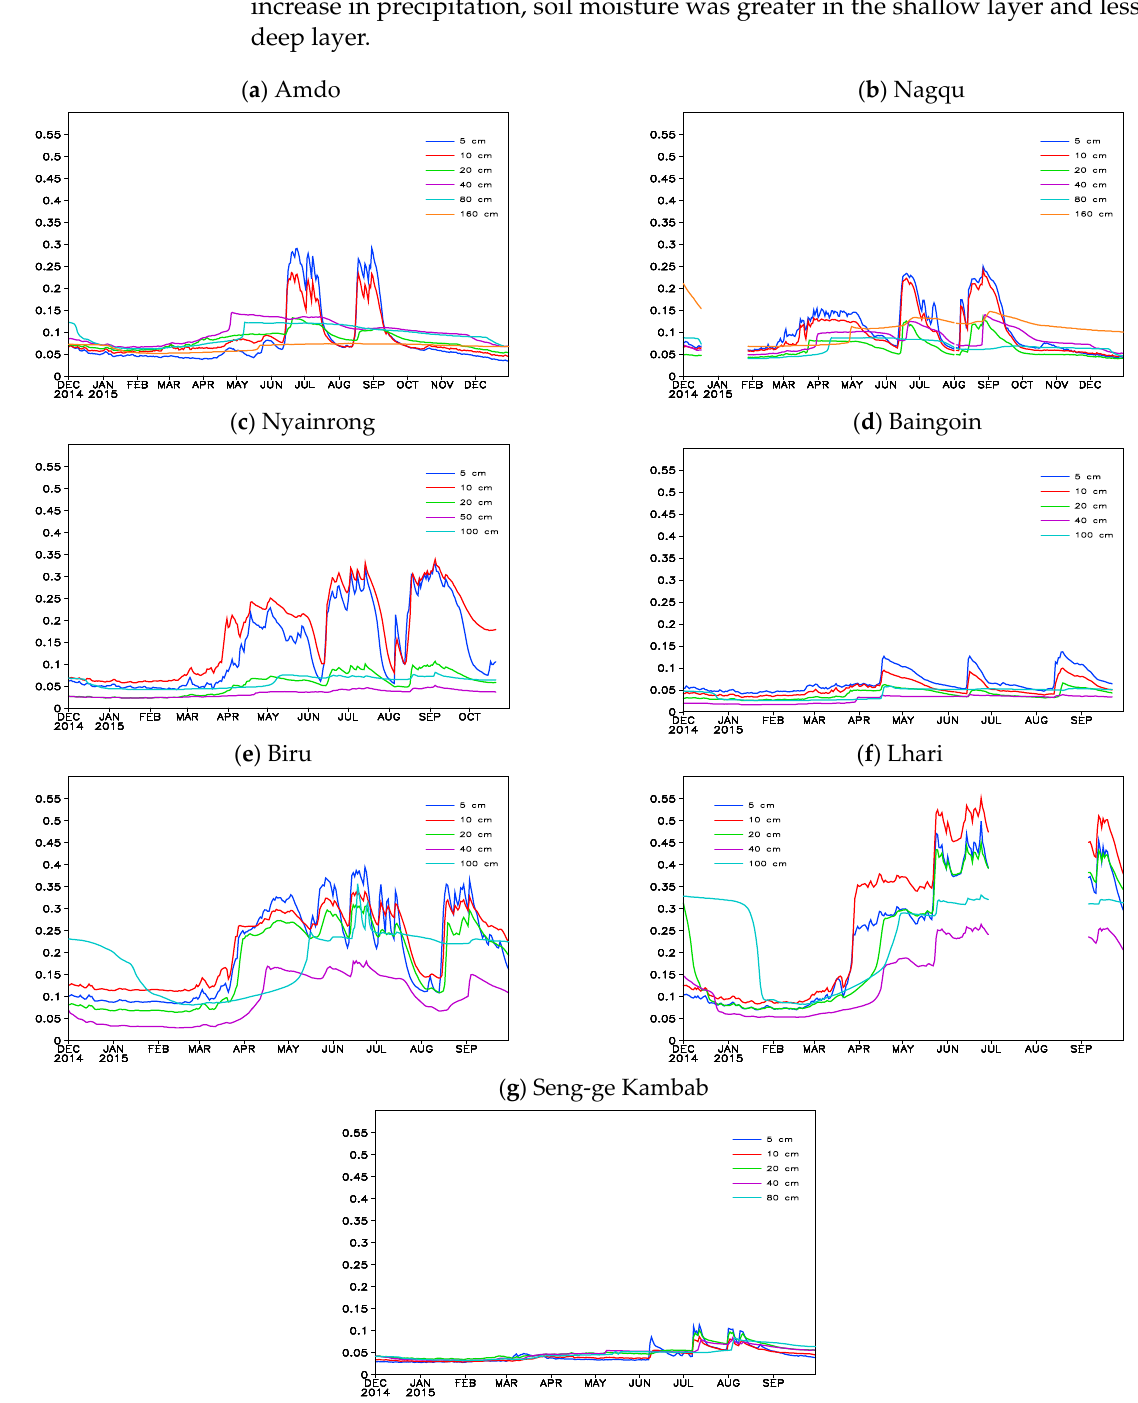
Figure 3. Time series of daily mean soil moisture at different depths (unit: cm 3 /cm 3 ). The lines break in the graphs represents the missing data, the same